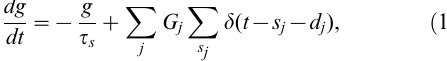
Figure S1 The plot of T versus a for different values of b . Blue horizontal line shows the target experimental value T = 2.73, red lines correspond to boundary values of b for which the target value is obtainable. (TIF) Figure S2 Possible parameter sets in the model. The values of parameters a , b , c1 and c2 are plotted for six parameter sets corresponding to K =1, 2, … 6. All these parameter sets give the experimentally measured values of the overall connectivity c = 0.1157, the overrepresentation of reciprocal connections R = 4.025 and that of triangle motifs T = 2.73. (TIF) Figure S3 Bistable dynamics of the network. (A) Mean field of the network (blue) and the external input (green). (B) Power spectrum in the low state. (C) Power spectrum in the high state.